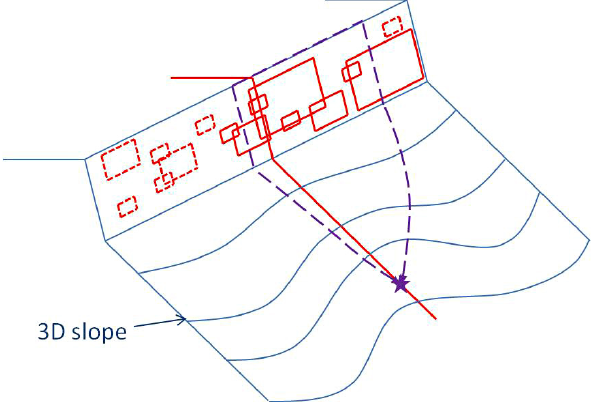
Fig. 4. 3-D slope with a punctual element at risk (star). The dashed line represents the area where a rock compartment must start to threaten the element at risk.